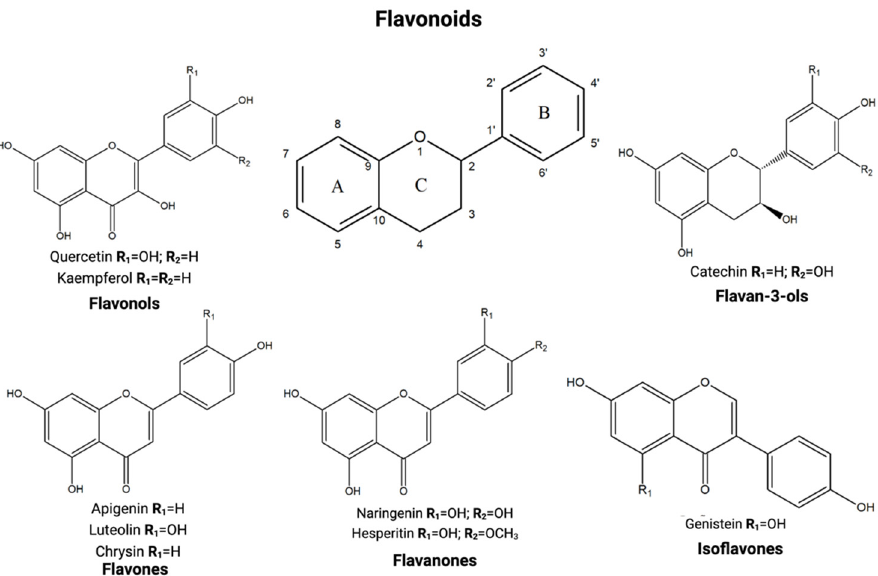
Figure 3. Chemical structure of the main subclasses of flavonoids found in Prunus avium L. by- products.